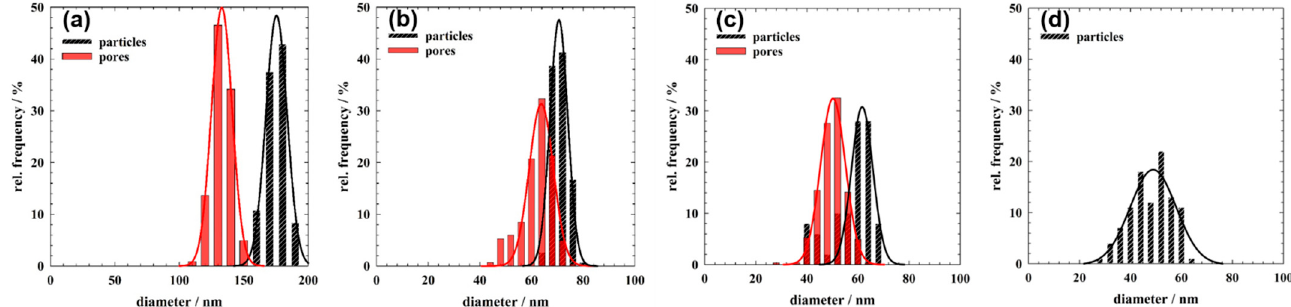
Figure 2. PS particle size distribution (black curve) and pore size distribution (red curve) in ( a ) PS175-T and Z175-IO, ( b ) PS70-T and Z70-IO, ( c ) PS60-T and Z60-IO and ( d ) PS48-T, respectively. Table 2. Average diameters d, standard deviations σ and polydispersities p = σ / d of the template particles and their corresponding ZnO IO pores obtained after three mineralization cycles and extraction with toluene. The % shrinkage is also represented. Template Inverse Opal % Shrinkage Particle Diameter ( d part ) (nm)